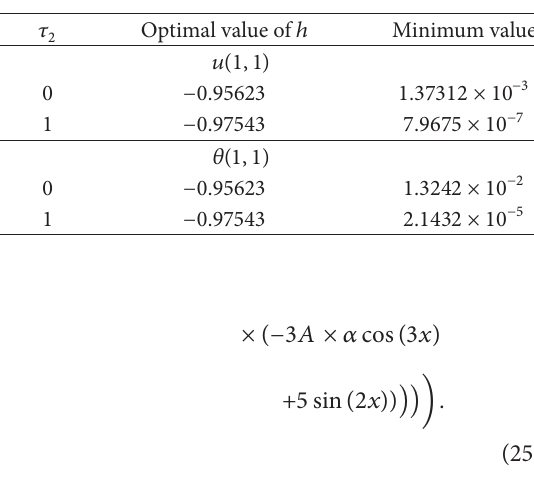
Table 2: The optimal values of ℎ at 5th-order approximate